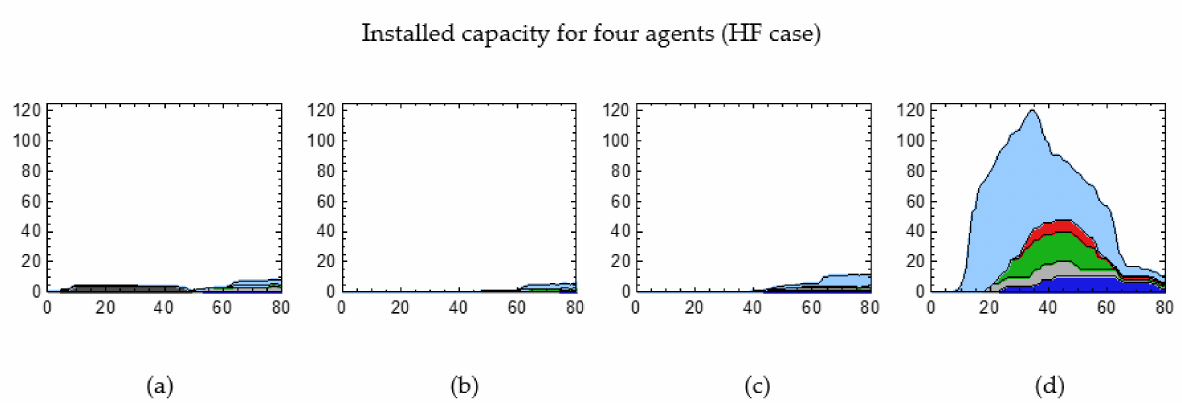
Figure 4. Illustration of the installed capacity for some agents in HF case. ( a ) β = 0.0, ( b ) β = 1.0, ( c ) β = 1.2, ( d ) β = 1.5. ( β is the multiplication factor of expectation of CO 2 tax). The agent with β = 1.5 dominates the investing in the first 50 years; afterwards, all agents contribute to investing in new